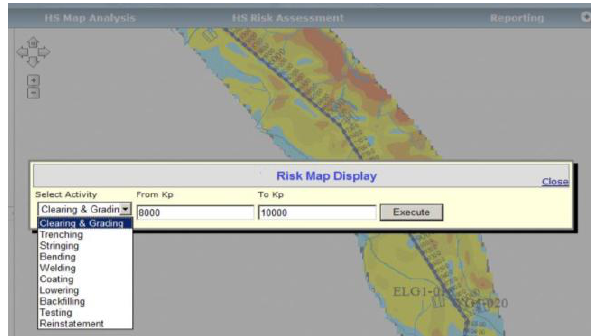
Figure8. User Interface for Information Entry